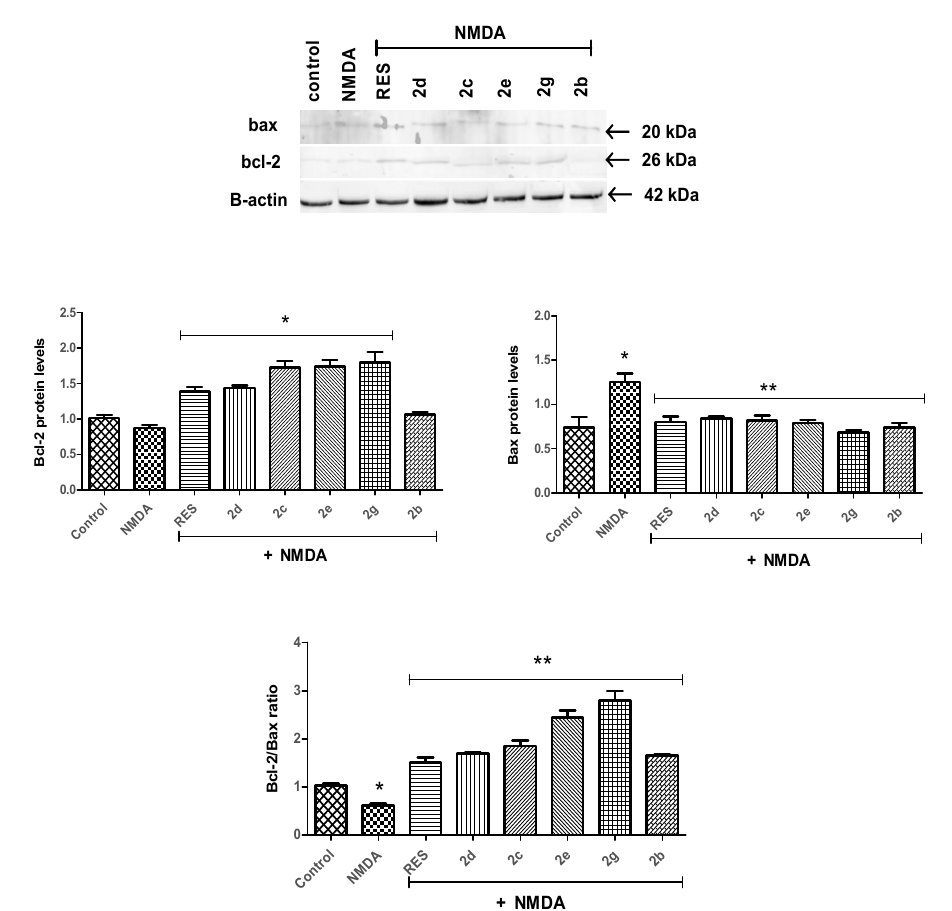
Figure 3. The alteration in Bax and Bcl-2 protein levels following amino-tomentosin derivative treatments in NMDA-treated cells. The concentration of 2c and 2d was 0.1 µ M and the concentration of 2b , 2e , and 2g was 1 µ M. Quantified band values were normalized to the corresponding β -actin signal. Bar graph data represent the mean ± SD; n = 3 independent experiments. * p < 0.05 significant difference from untreated cells; ** p < 0.01 significant difference from NMDA-treated cells.